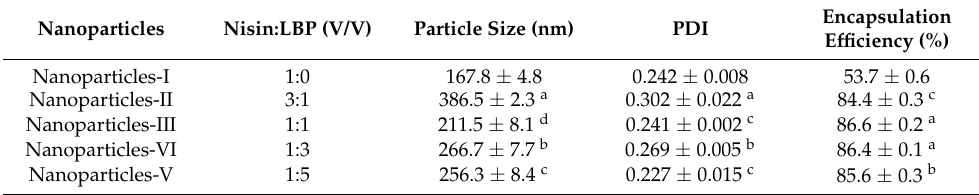
Table 1. The Particle size, PDI and encapsulation efficiency of nanoparticles.